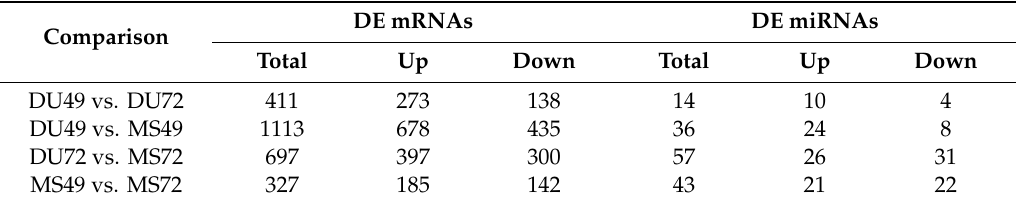
Table 1. Number of di ff erentially expressed mRNAs and miRNAs.